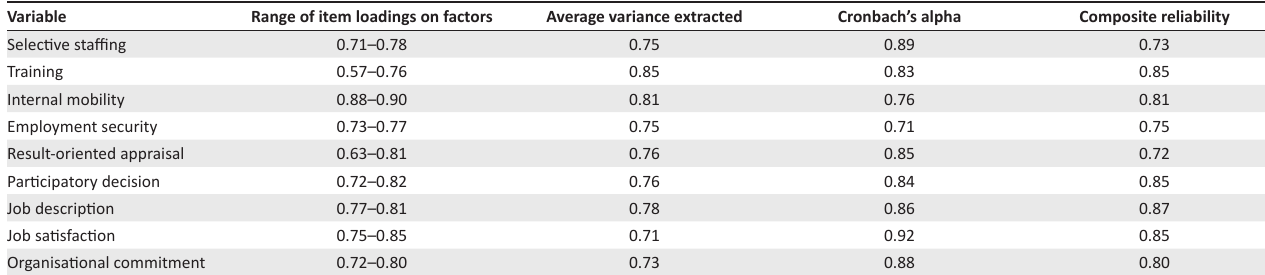
TABLE 3: Convergent validity